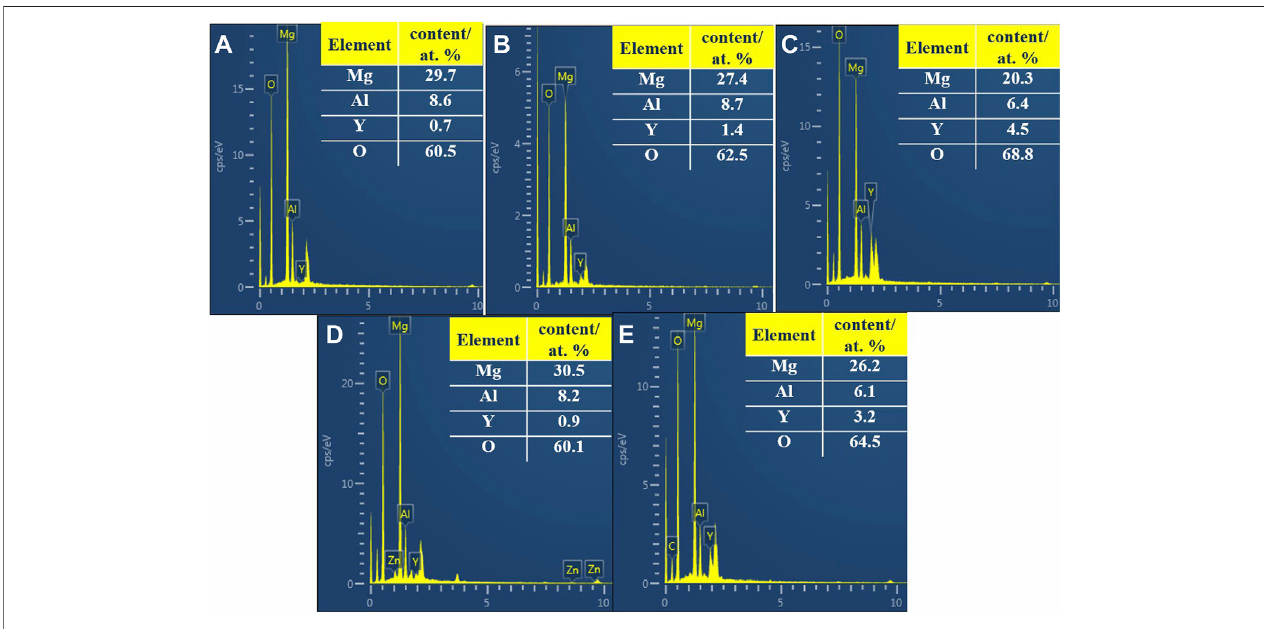
FIGURE 3 | EDS spectra of the corresponding points in Figure 2 : 20Y [ (A) , 1]; 40Y [ (B) , 2]; 60Y [ (C) , 3]; 80Y [ (D) , 4]; and 0Y [ (E) , 5].